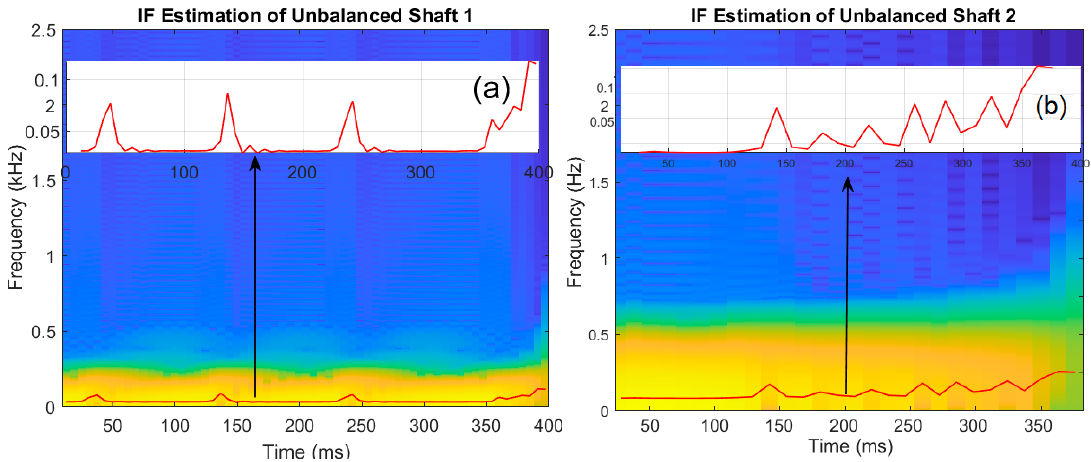
Figure 10. Experimental instantaneous frequency estimation of ( a ) unbalanced driveshaft, ( b ) unbalanced driven shaft.